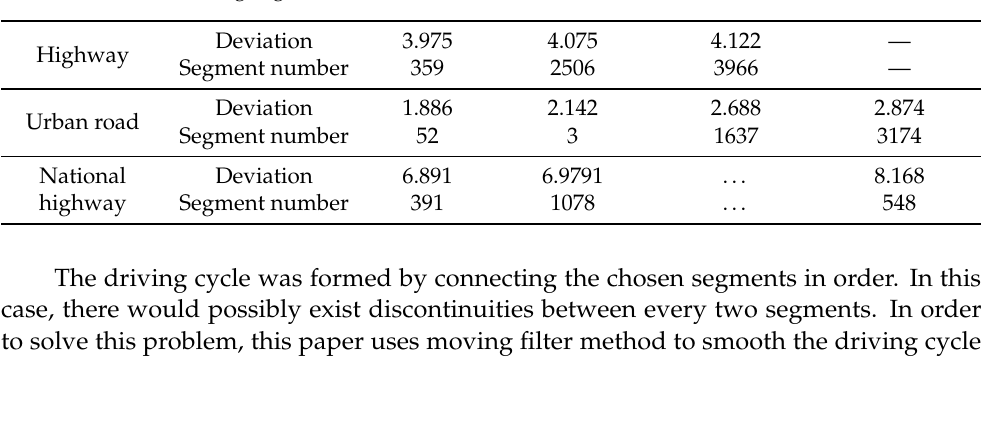
Table 4. Selected driving segments and their